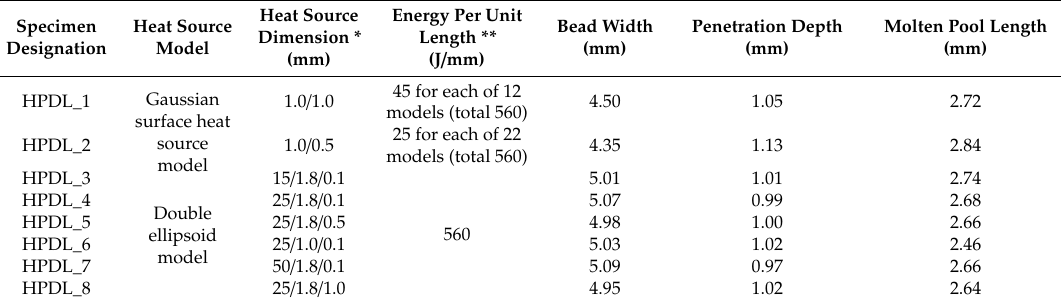
* Dimensions for the Gaussian surface heat source model: diameter / distance between trajectories (mm); for the double-ellipsoid model: width / length / height of model. ** Heat transfer e ffi ciency coe ffi cient: 0.5 (determined on the basis of model calibration based on actual bead dimensions).